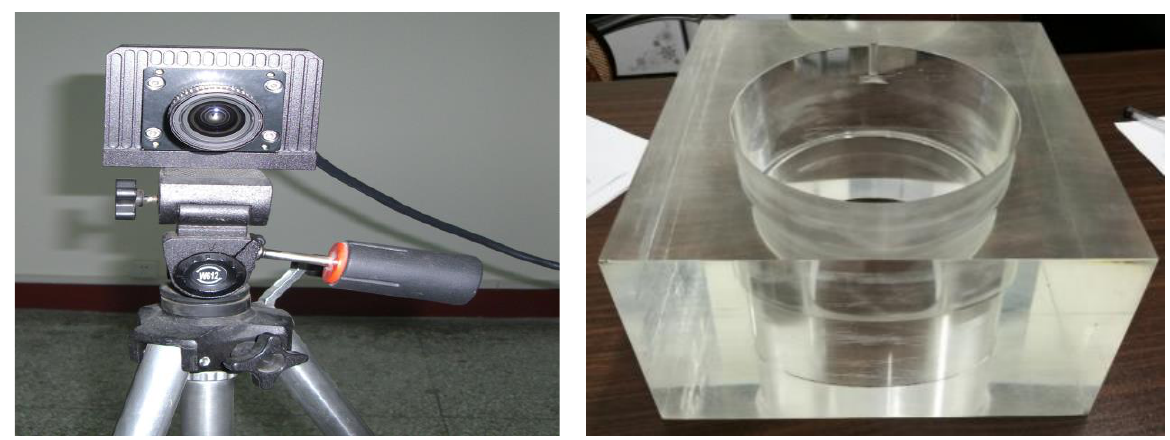
Figure 6. High speed camera and transparent glass component.